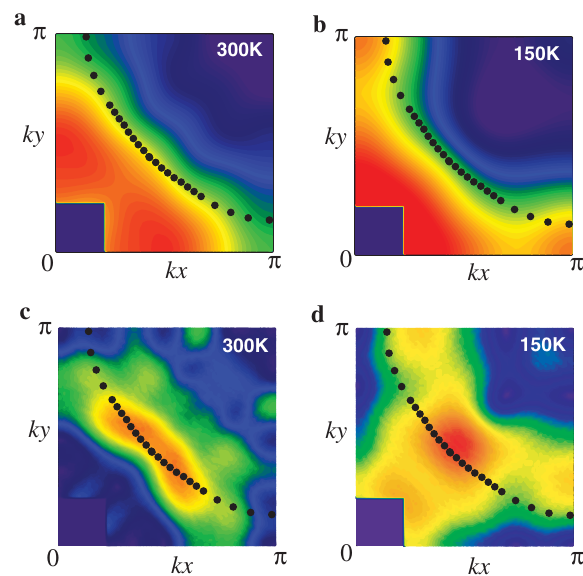
Fig. 2 Interpretation of Fig. 1a, b in terms of the conventional Fermi surface (FS) (dots) reported by angle-resolved photoemission spectroscopy (ARPES) (ref. 9 ). a and c are the momentum distribution function n ( k ) and the magnitude of its derivative ∣ ∇ n ( k ) ∣ at 300 K in the fi rst quadrant of the Brillouin zone, respectively; b and d are the corresponding results at 150 K. Although the ARPES measurements were performed for La 2 − x Sr x CuO 4 with x = 0.07 (ref. 9 ), the doping difference by 1% from the present study provides no visible change of the FS on the scale of the fi